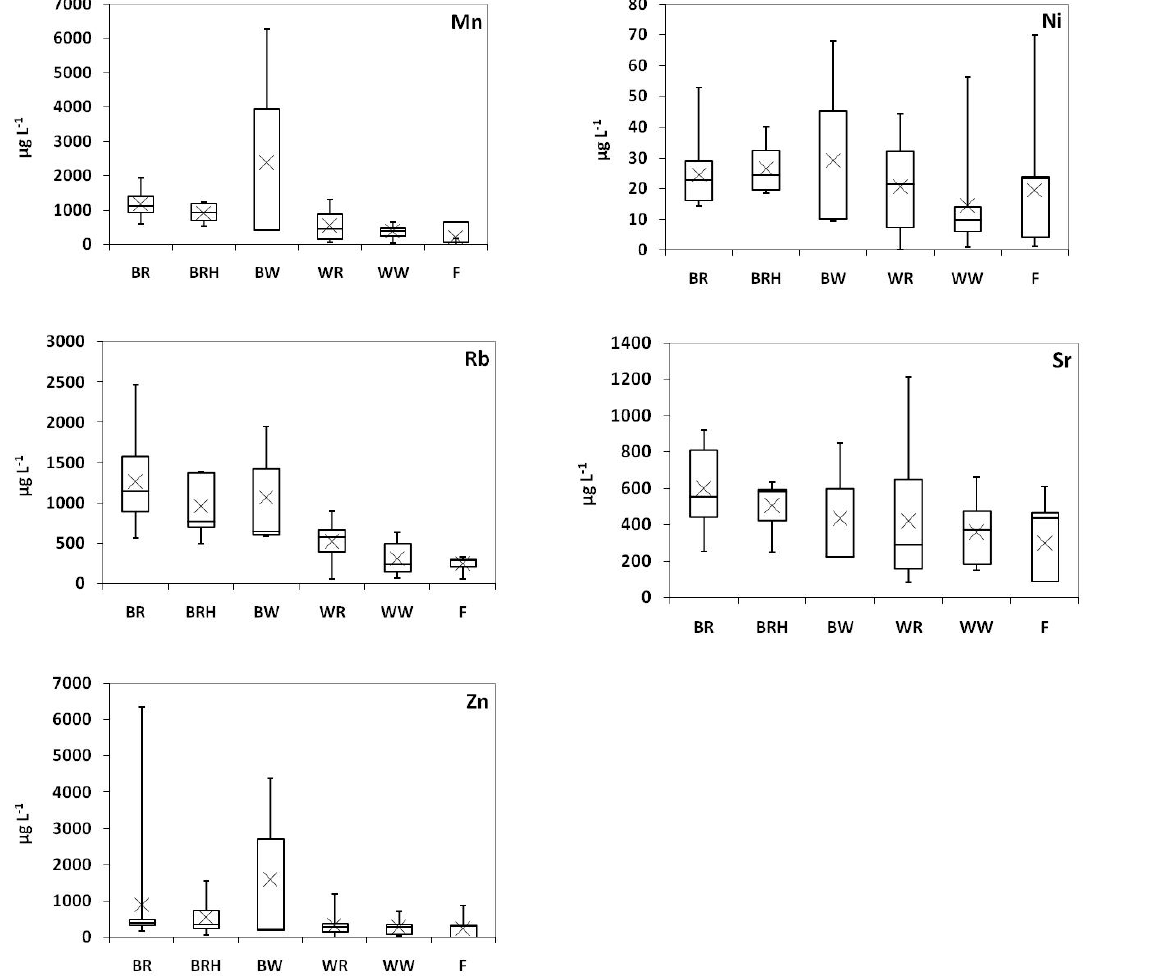
Figure 2. Plots of trace metals determined for all vinegar samples examined. The mean value is displayed with x. (BR: balsamic red vinegar; BRH: balsamic red vinegar with honey; BW: balsamic white vinegar; WR: wine red vinegar; WW: wine white vinegar; F: fruit vinegar).